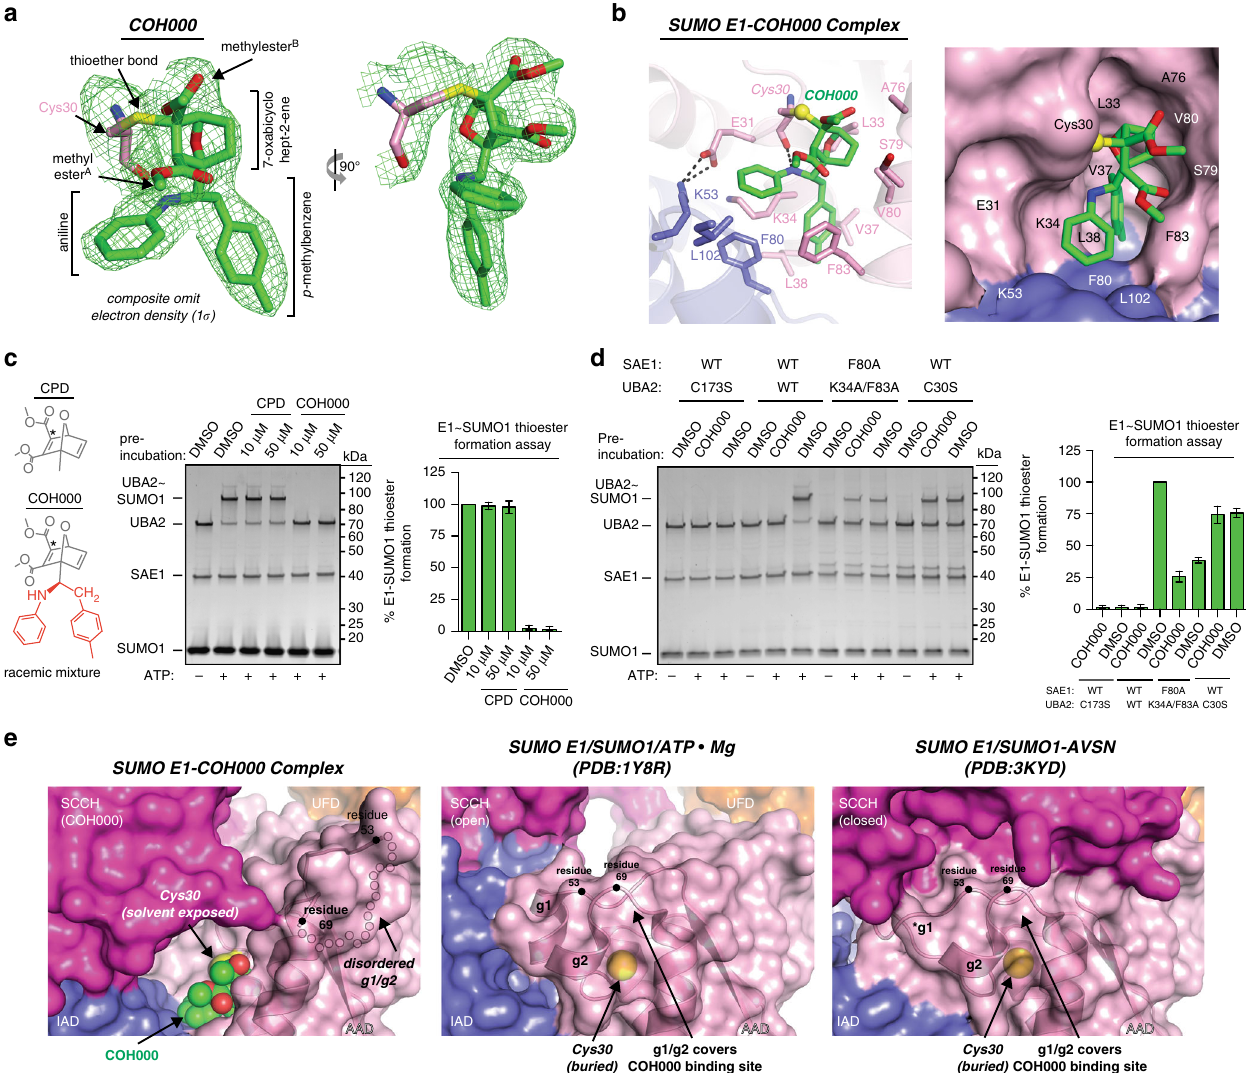
Fig. 2 COH000 targets a cryptic binding site on SUMO E1. a Composite omit electron density map (contoured at 1 σ ) for COH000 is shown as green mesh. COH000 is shown as sticks with carbons (green), oxygens (red), and nitrogens (blue). Cys30 of the AAD is shown as sticks with sulfur (yellow). b (top) The SUMO E1 COH000 structure is shown as a cartoon (colored as in Fig. 1a), with COH000-interacting residues shown as sticks. Hydrogen bonds are shown as dashed lines. b (bottom) SUMO E1 is shown as a surface representation to highlight the COH000 binding pocket. SUMO E1 residues involved in contacts to COH000 are labeled. c The core structure containing the Michael acceptor of COH000 is not suf fi cient to achieve inhibition. The compound L163392 from Aldrich (labeled CPD) was compared side by side with COH000 for biochemical inhibition of SUMO E1 using SUMO E1~SUMO1 thioester formation assays as described in the Methods. Data from three independent experiments were quantitated and presented as bar graphs, with error bars representing ± 1 SD. Chemical structures are shown on the left with the Michael acceptor of COH000 highlighted with a black star. d SUMO E1 – SUMO1 thioester formation assays were performed with the indicated SUMO E1 variants in the presence and absence of COH000 as described in the Methods. Data were quantitated as in c . C173S serves as a catalytically inactive negative control. e The indicated SUMO E1 structures are shown as semitransparent surface representations with selected regions shown as cartoons. COH000 is shown as spheres. The disordered g1/g2 region in the SUMO E1 COH000 structure is shown as semitransparent circles and the residues marking the beginning and end of this disordered region (residues 53 and 69) are highlighted with a black circle in all the structures to allow for direct comparison. The asterisk highlights the g1 helix that undergoes structural